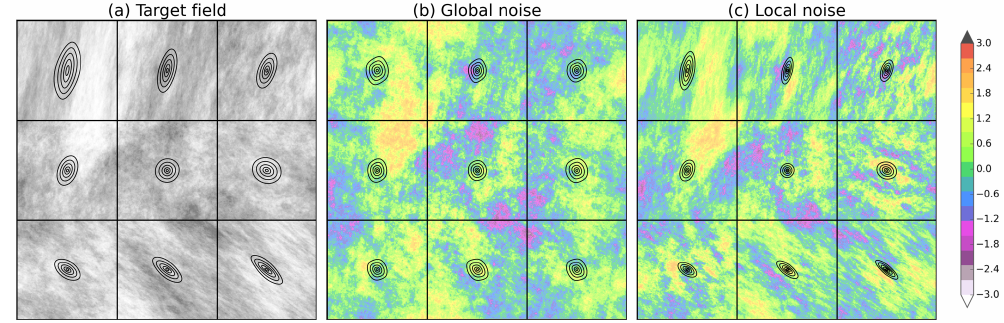
Figure 5. (a) An example of 512px × 512px non-stationary correlated Gaussian noise generated using parametric filtering. The GSI param- eters (see Niemi et al., 2014, for details) linearly evolve from G ( − 0.12, − 0.12, − 0.12) and I s = 5 at the upper-left corner to G (0.12, 0.12, 0.12) and I s = 5 at the lower-right corner of the image. The black contours show the corresponding autocorrelation functions at 0.5, 0.6, 0.7, 0.8 and 0.9 correlation coefficients. Non-parametric stochastic realisations of the target field using a global generator (b) and a local SSFT generator (c) with Hanning windows centred over the grid boxes in the image. All simulations have been drawn from the standard normal distribution and share the same random seed.